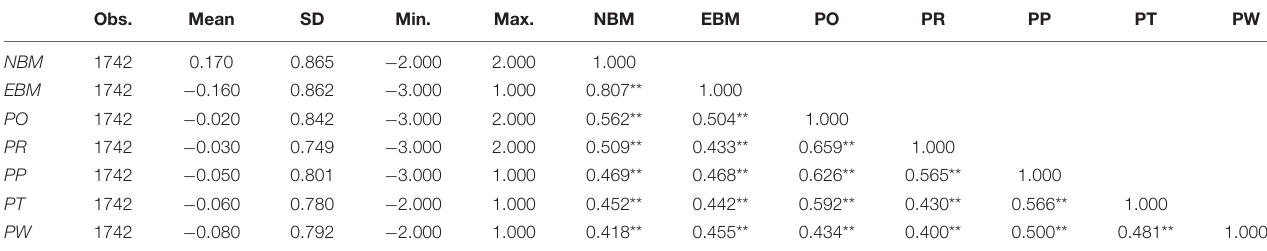
TABLE 1 | Descriptive statistics and correlation coefficients.